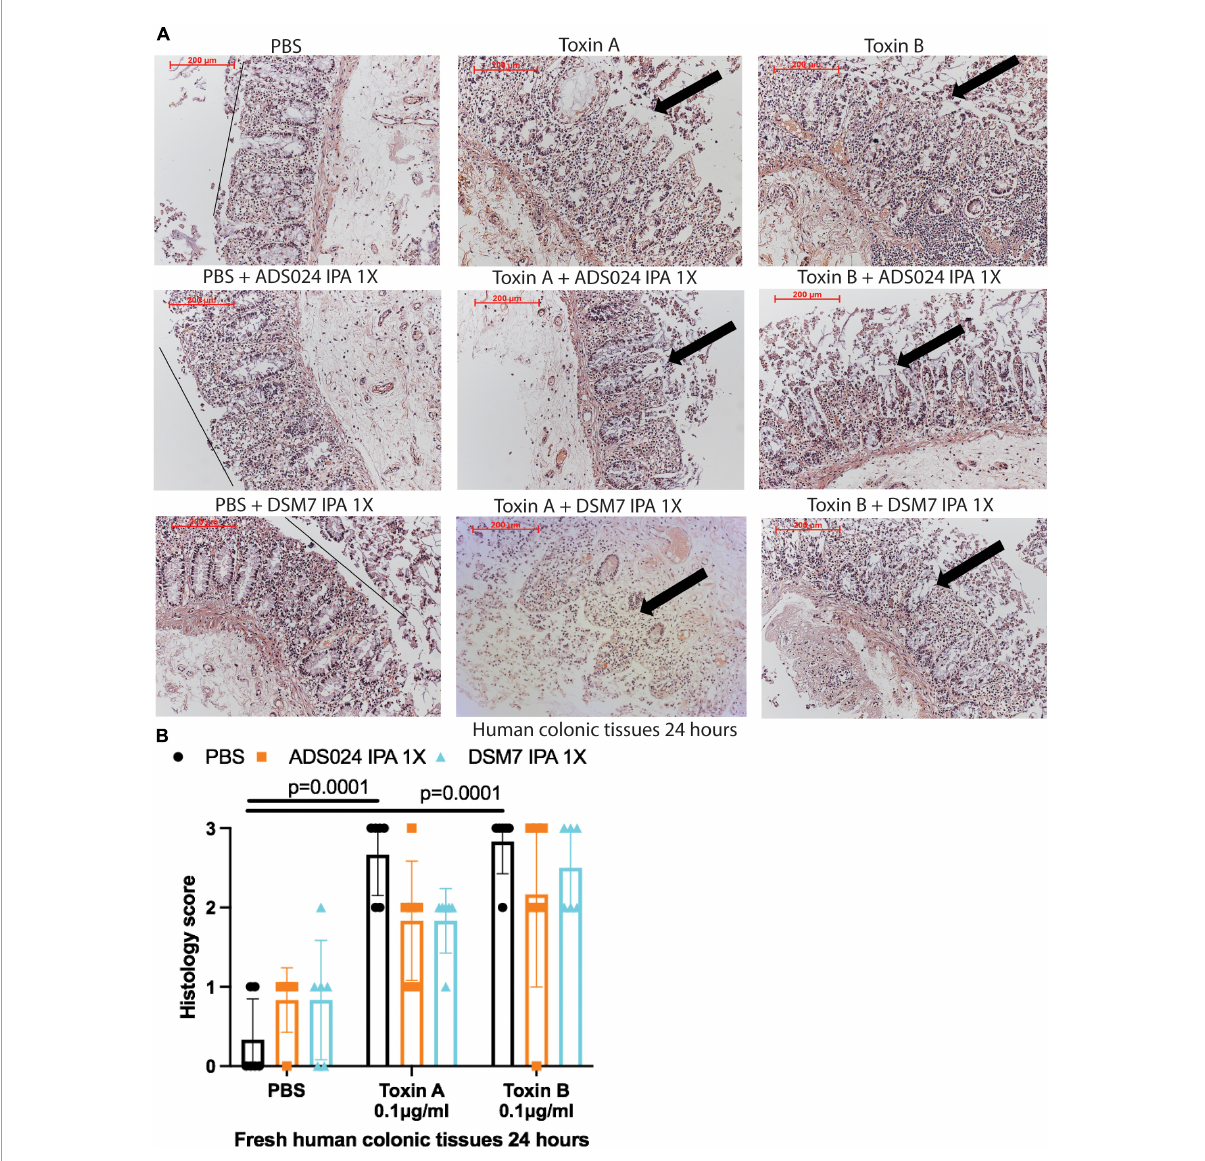
FIGURE3 ADS024 isopropanol extract did not affect toxin-mediated epithelial injury in fresh human colonic explants. Fresh human colonic explants were placed in serum-free RPMI1640 media with PBS or 0.1% v/v of IPA extracts of ADS024 and DSM7 at 1X. Thirty minutes later, toxin A and toxin B (0.1 µ g/ml) were added and further incubated for 24 h. (A) H&E-stained images at 100X magnification. Black lines indicated the integrity of the top lining of colonic mucosa in PBS control groups. Arrows indicated toxin-mediated disruption of mucosal integrity and thickness. (B) Histology scores for epithelial injury (0–3). ADS024 and DSM7 IPA extracts did not affect toxin-mediated epithelial injury. Results were pooled from samples from 10 patients. One-way ANOVA tests were